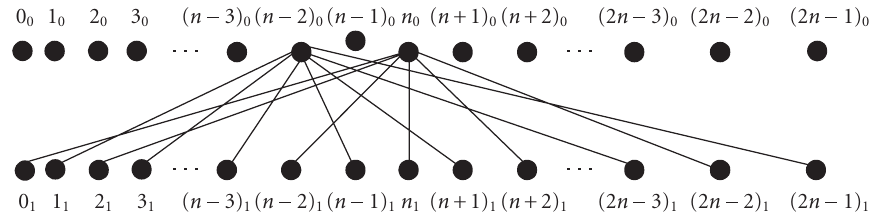
Figure 5.1. Symmetric starter of an ODC of K 2 n ,2 n by G = 2 S n ∪ E 2 n − 2 with respect to Z 2 n , n is even.